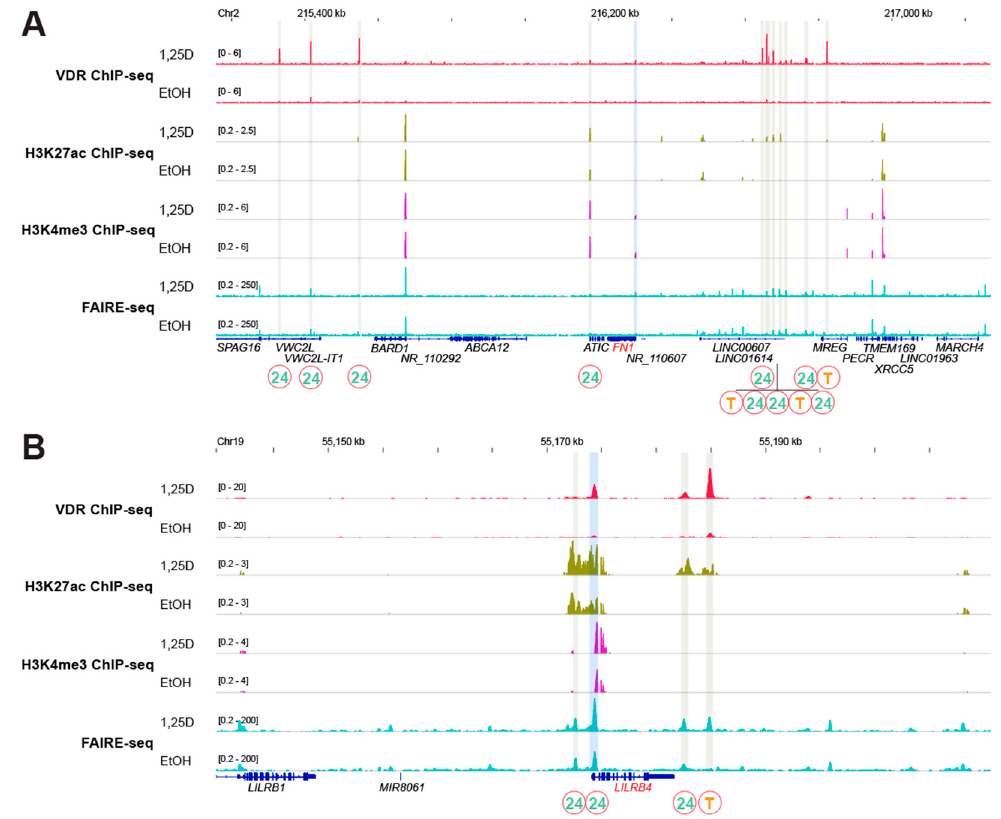
Figure A2. Vitamin D target genes controlled by ligand-dependent single enhancers. The IGV browser was used to visualize VDR ChIP-seq results (red) obtained in THP-1 cells that had been treated for 24 h with 1,25(OH) 2 D 3 (1,25D) or solvent (EtOH) [28]. VDR-bound enhancers are shaded in grey and non-ligand-dependent TSS regions in blue. The type of VDR binding sites at enhancers is indicated as transient (T) or 24 h only (24) [28]. These data are compared with ChIP-seq results obtained under the same conditions for histone markers of active chromatin (H3K27ac, green) [35] and active TSS regions (H3K4me3, purple) [35] as well as with FAIRE-seq data (turquoise) [29]. The peak tracks display merged data from the three biological repeats. Gene structures are shown in blue and the vitamin D target genes FN1 ( A ) and LILRB4 ( B ) are highlighted in red. The genomic regions 1 Mb up- and downstream of the gene’s TSS were inspected but only the areas relevant for 1,25(OH) 2 D 3 -dependent regulation are displayed.